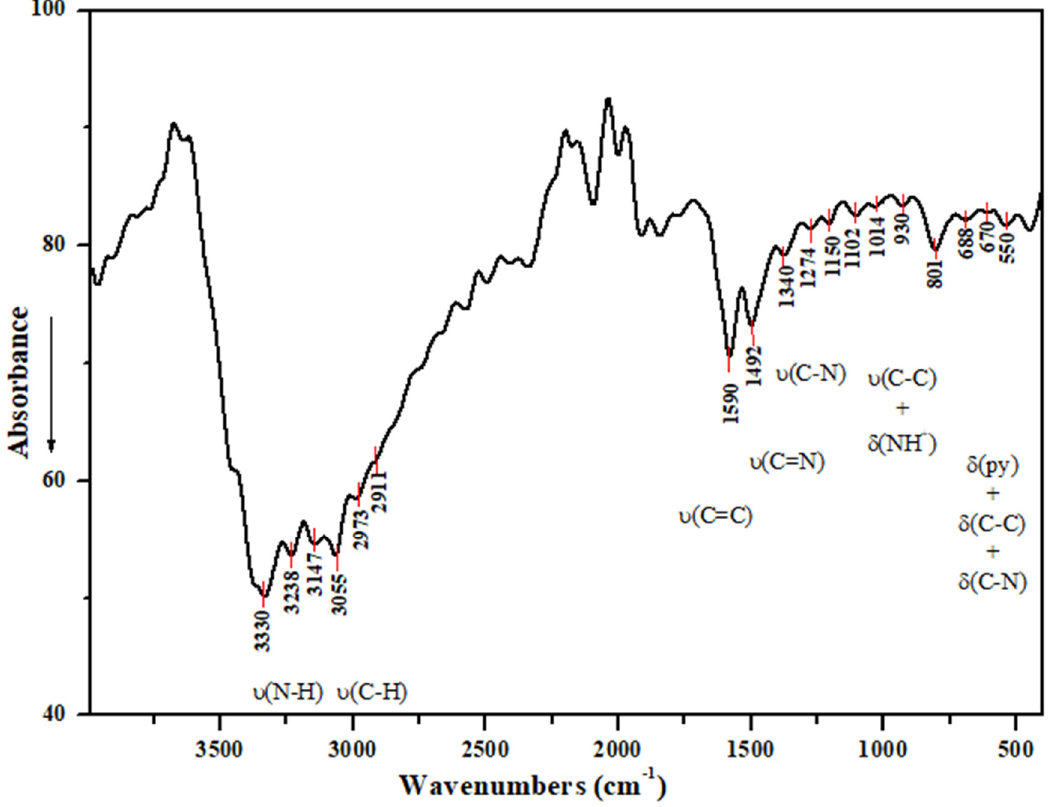
Figure 8. The IR spectrum of (C 9 H 14 N) 2 [CuCl 4 ] taken at room temperature.